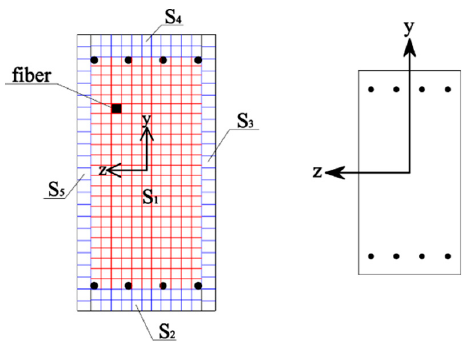
Figure 12. The cross section of Nonlinear Beam Column elements.